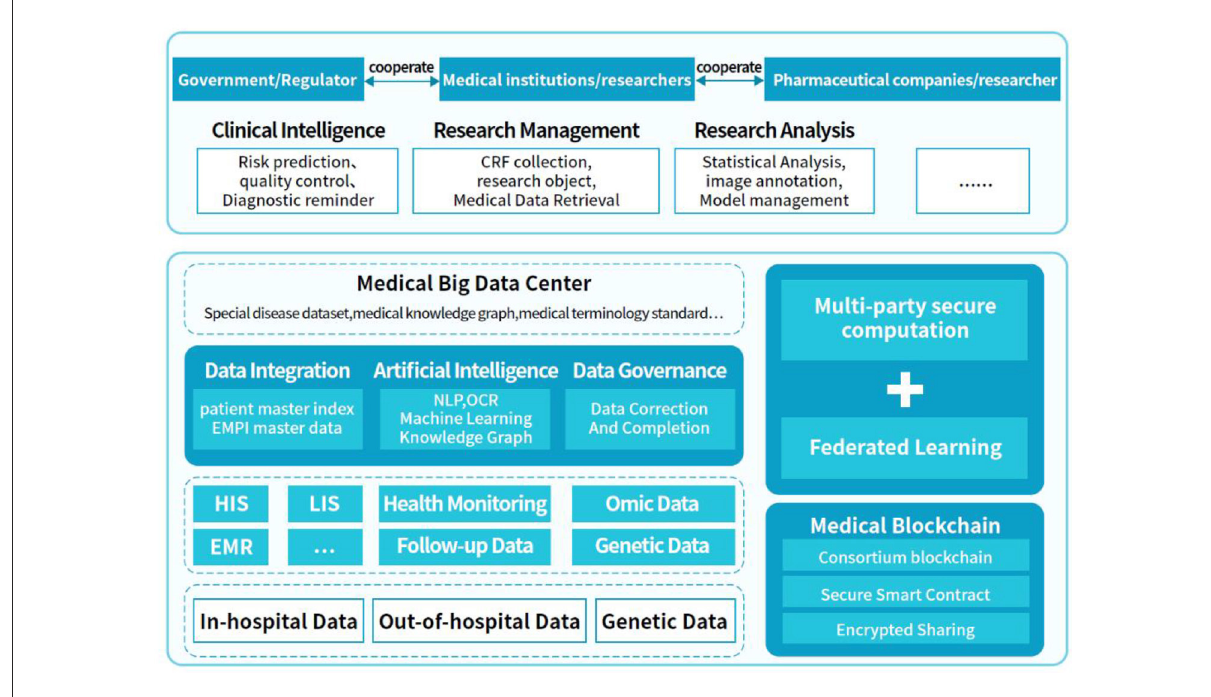
FIGURE1 RDDP platform architecture